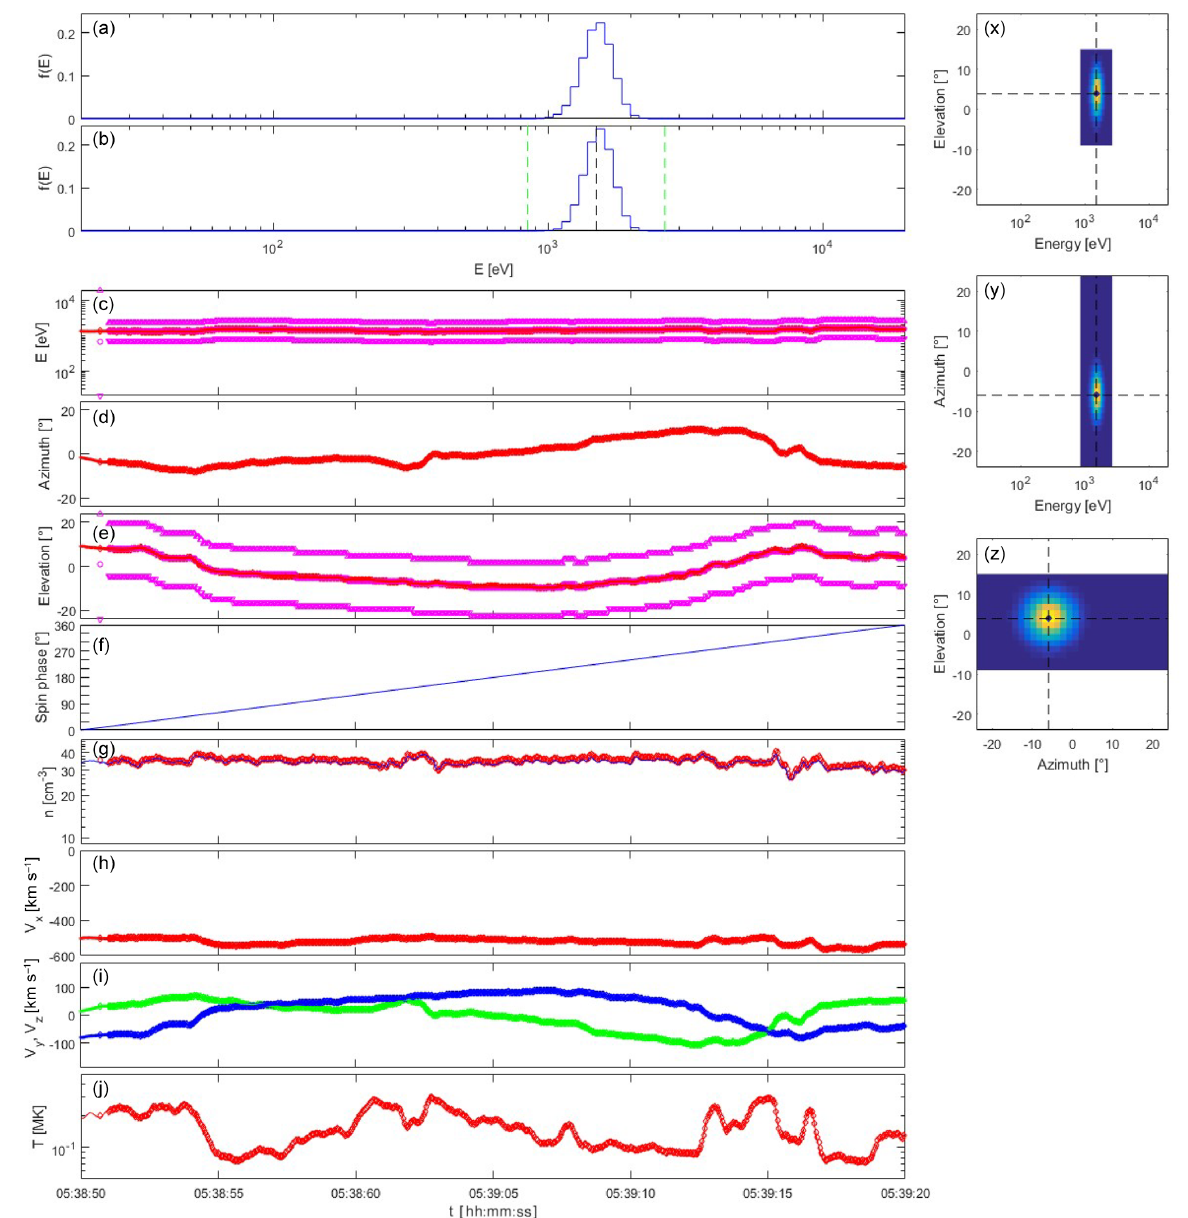
Figure 7. Plasma spectrometer measurements for a solar wind simulation based on Spektr-R/BMSW observations on 8 June 2014, using internal energy and elevation beam tracking. The plot layout is the same as that of Fig. 1, but also shows (g) density, (h, i) velocity in the spacecraft frame of reference ( x axis pointing to the Sun, spacecraft spinning in the x – y plane), and (j) temperature, as a function of time.